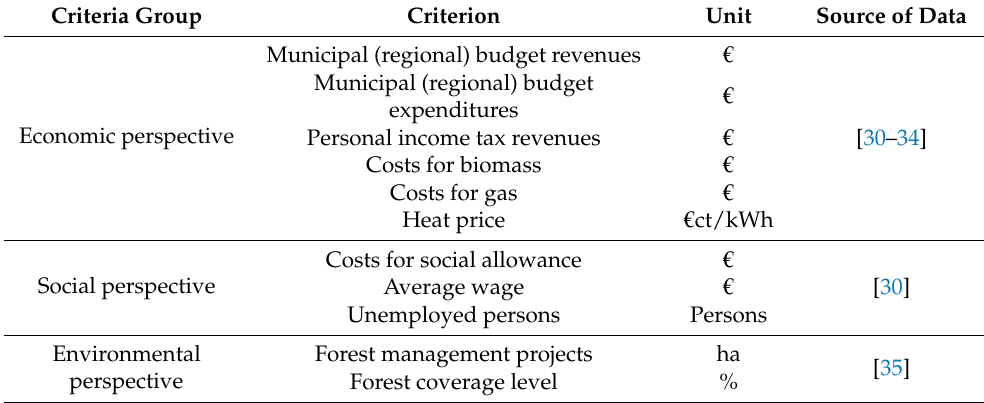
Table 2. Required data for the